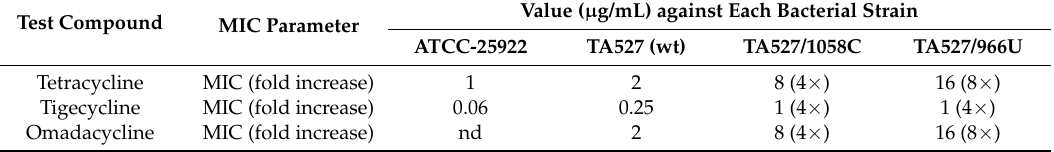
Minimal inhibitory concentrations of TET, TGC, and OMC for E. coli strains with tetracycline-sensitive and tetracycline-resistant